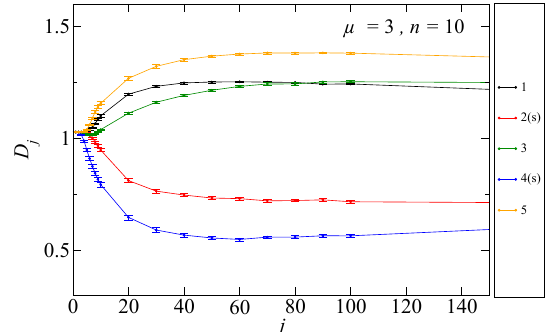
Figure 8. Box-counting fractal dimension for quiet and active states, as a function of j , with µ = 3. Numbers for each curve label the states. We added an “(s)” in the legends, in order to highlight the active states. (Taken from Domínguez et al.,